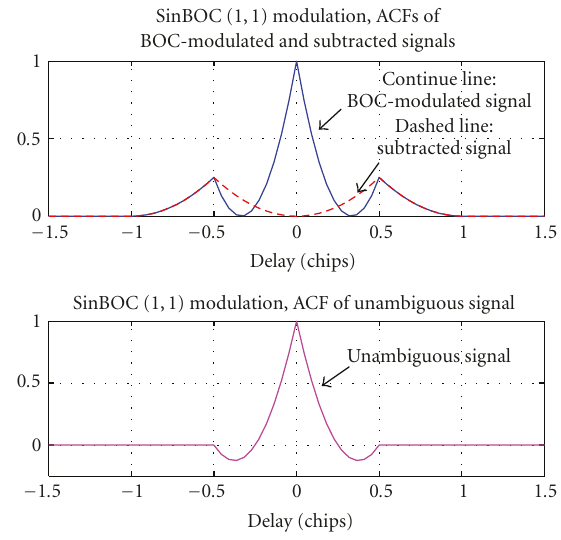
Figure 8: SinBOC(1,1)-modulated signal: examples of the ambigu- ous correlation function and subtracted pulse (upper plot) and the obtained unambiguous correlation function (lower plot), for a single-path